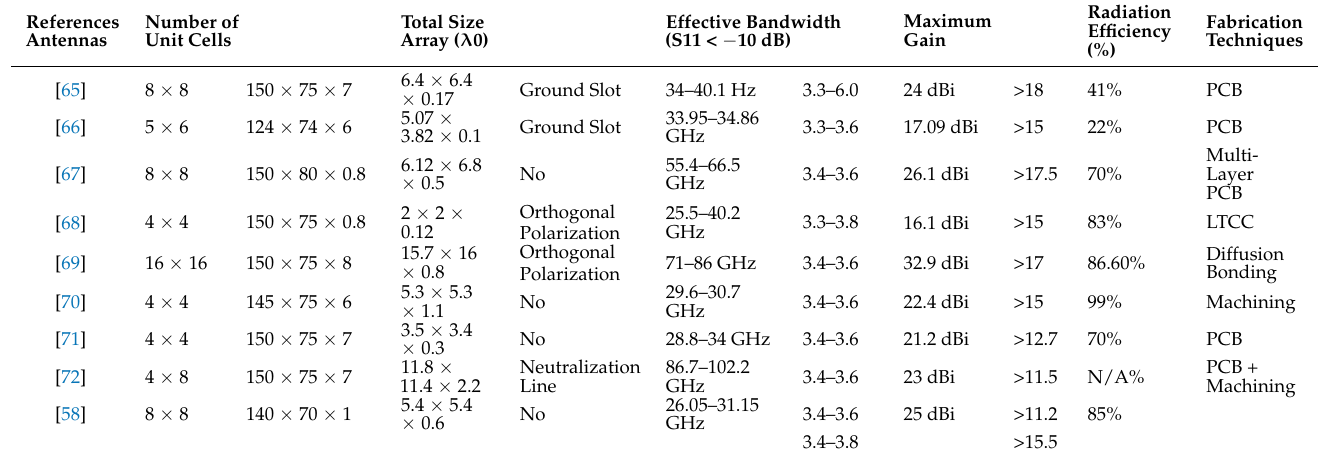
Table 2. A Summary of different Antennas Performances with Different Fabrication